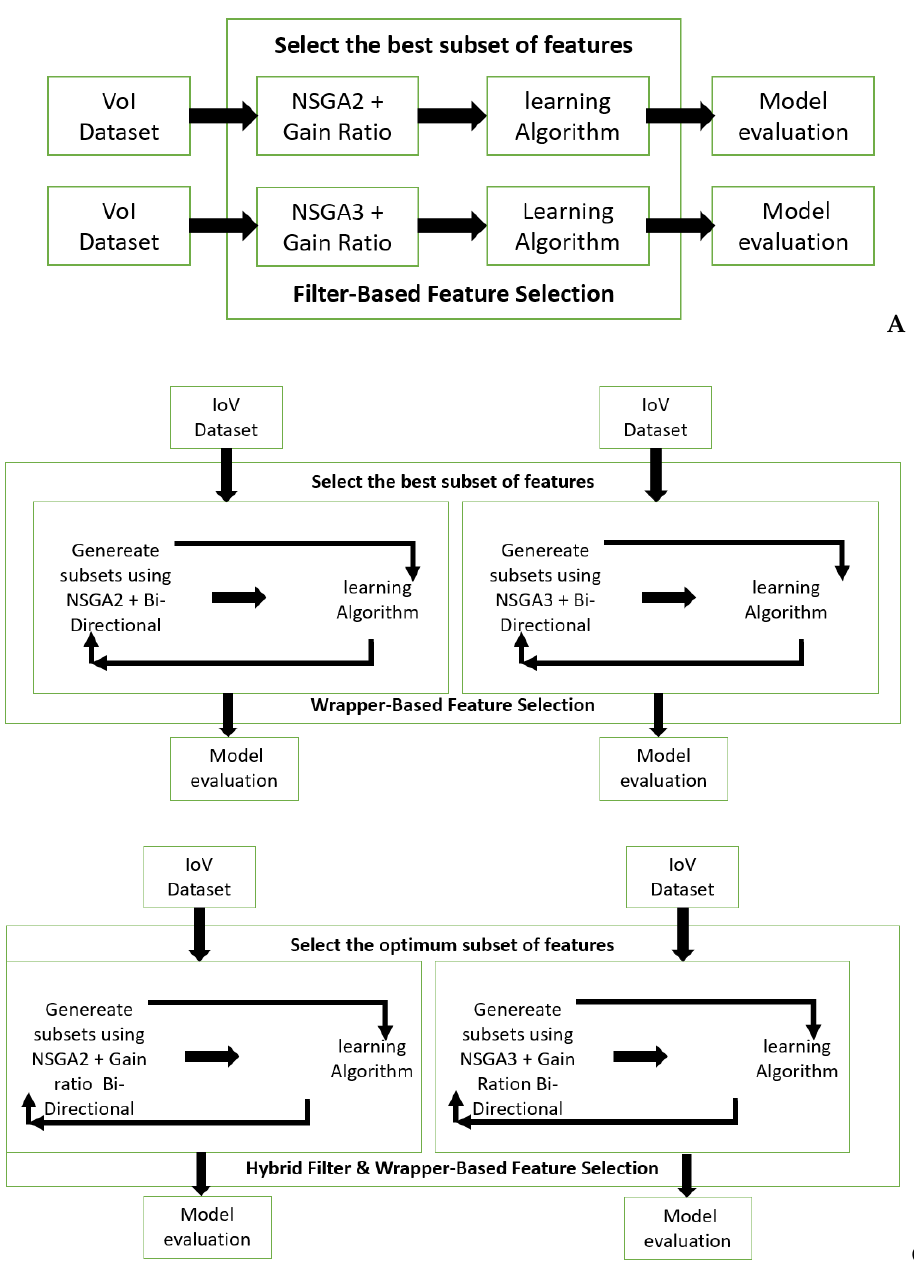
Figure 3. Propose framework for subset selection: ( A ) NSGA3 + GR, ( B ) NSGA3 + Bi-directional and ( C ) the NSGA3 + Bi-directional + GR.